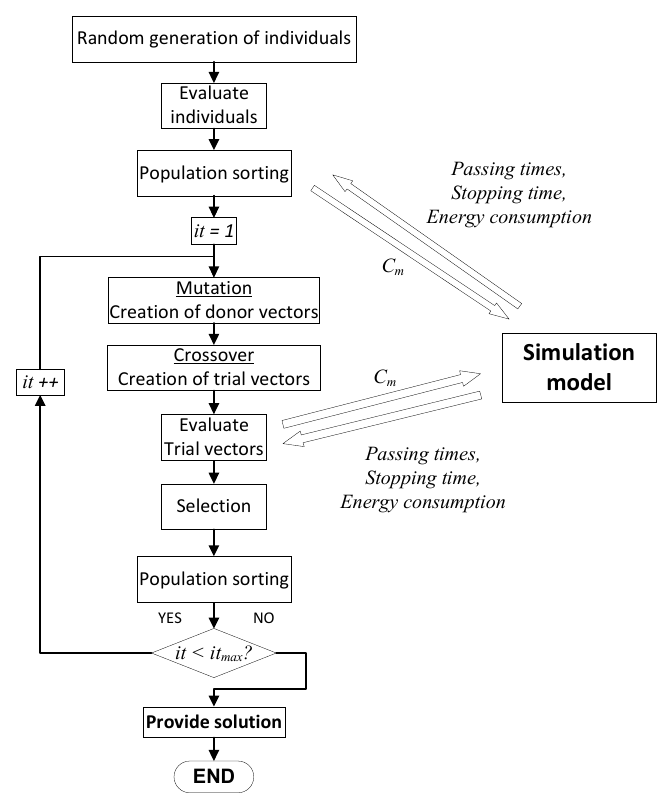
Figure 1. Optimization method flowchart.